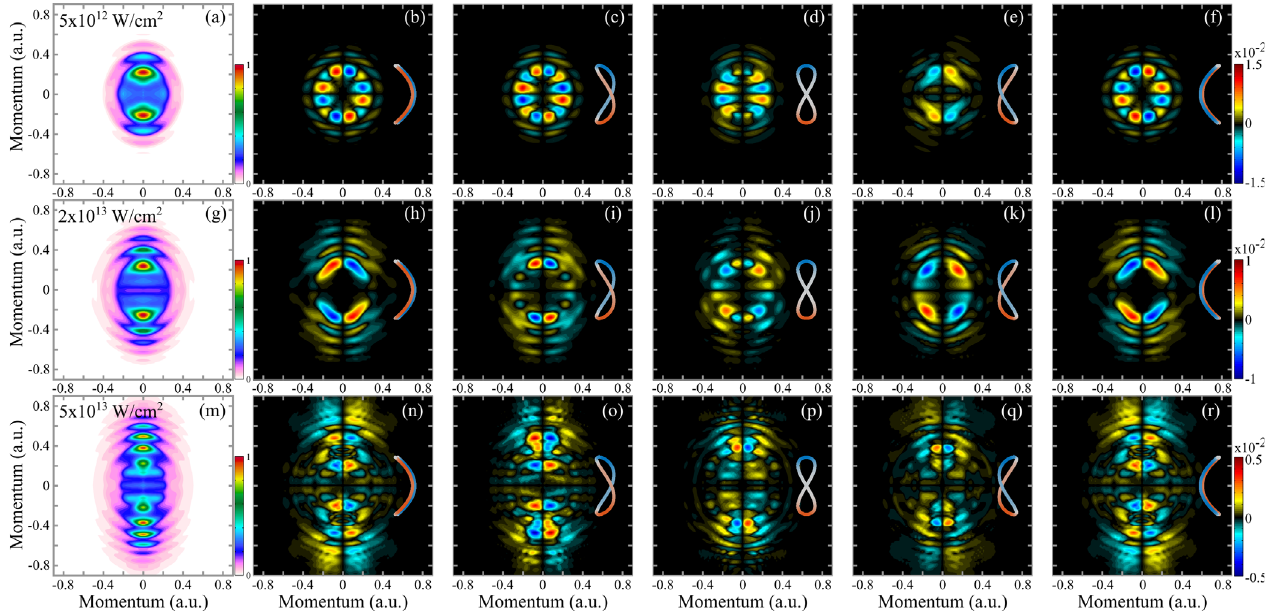
FIG. 3. TDSE calculations of photoionization of a toy model chiral molecule by a composite bichromatic field. (a),(g),(m) Projections in the y - z plane of the symmetric part of the photoelectron spectrum, at I ¼ 5 × 10 12 (a), 2 × 10 13 (g), and 5 × 10 13 W = cm 2 (m). The Keldysh parameter for these calculations is γ ¼ 3 . 9 , γ ¼ 1 . 9 , γ ¼ 1 . 2 respectively. (b) – (f),(h) – (l),(n) – (r) Corresponding projections of the ESCARGOT signal, defined as the antisymmetric part of the photoelectron distribution with respect to the propagation axis z and fundamental laser polarization axis y . The relative phase between the two components of the laser field is φ ¼ 0 , π = 4 , π = 2 , 3 π = 4 , and π from left to right. The shape of the two-color field, colored according to the instantaneous chirality, is shown next to each